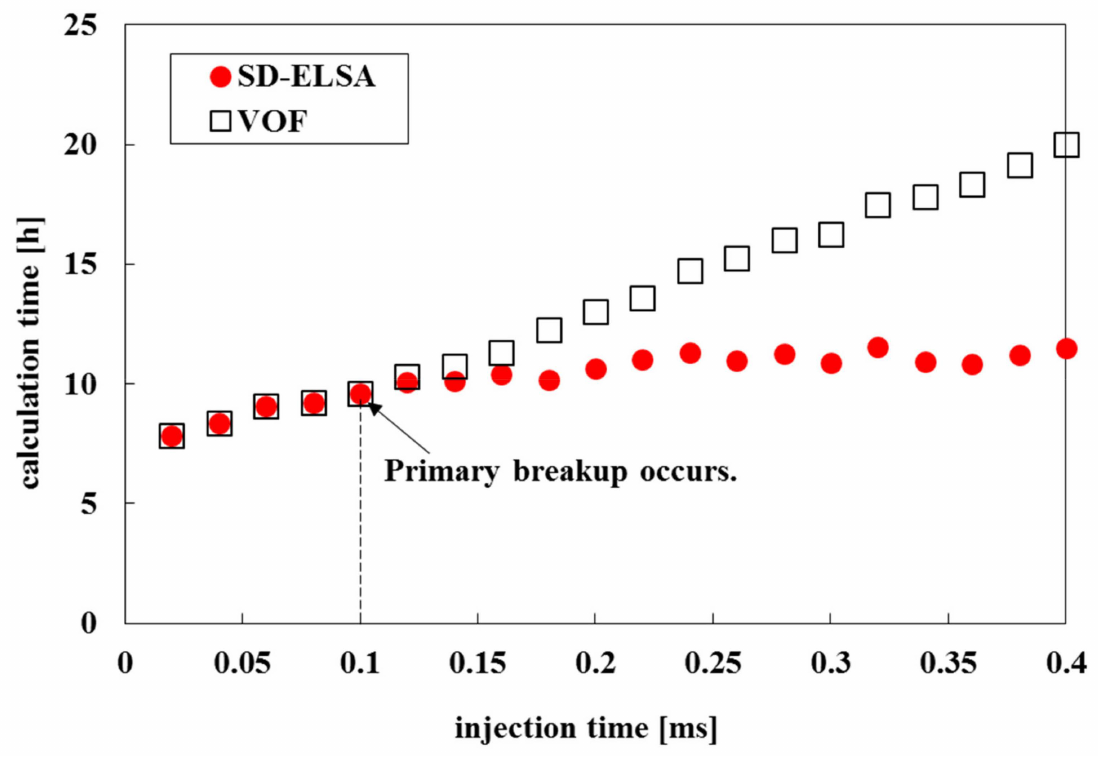
Figure 8. Comparison of calculation time between SD-ELSA and VOF model. ( p injection = 100 MPa, p b = 1